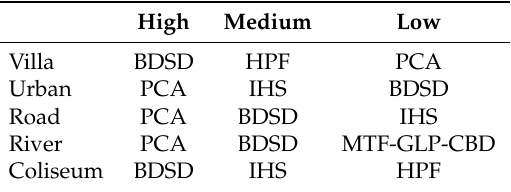
Table 16. Clustering of pan-sharpening algorithms applied to IKONOS Roma Villa, Urban, Road, River, and Coliseum scenes’ data into high, medium, and low performance. Input data for clustering are the full-resolution image quality assessment (IQA)-based indexes Q S , Q C , Q D , and Q NIQE , Q OA in Tables